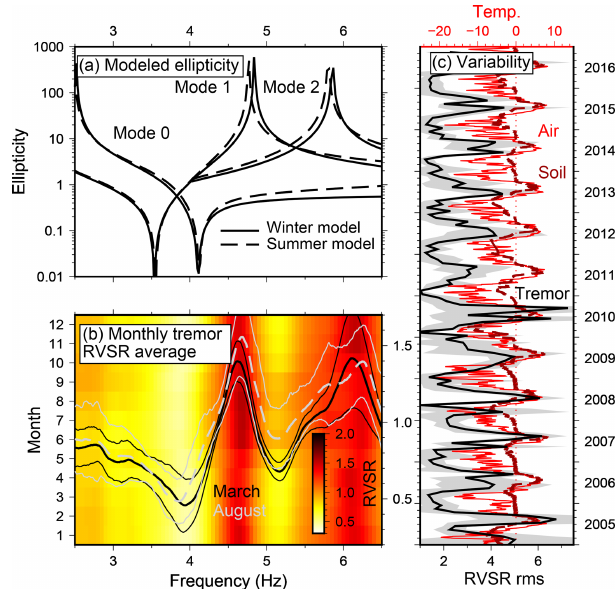
Figure 7. (a) Rayleigh wave ellipticities for fundamental and two higher modes in the tremor frequency band computed from the ref- erence model and modified model by introducing a 2m thick top low-velocity layer supposed to represent a thawed active permafrost layer. (b) Temporal variation of tremor radial-to-vertical spectral ra- tios (RVSRs) averaged over individual months and the years 2010– 2016. Average RVSRs for March and August and standard devia- tions show that the seasonal change in amplitude is significant and consistent ( p < 0 . 01 between 4.0 and 5.8Hz for Welch’s T test). (c) Air temperature measurements in Ny-Ålesund (10-day running average), soil temperature at 0.59m depth (dark red dashed; Boike et al., 2018), and monthly averaged root mean square (rms) dif- ference for frequency range (4.0–5.5Hz) between averaged RVSRs in February 2016 and each tremor RVSR. Standard deviations are shown as gray areas. The years 2001–2004 are not shown because of long data